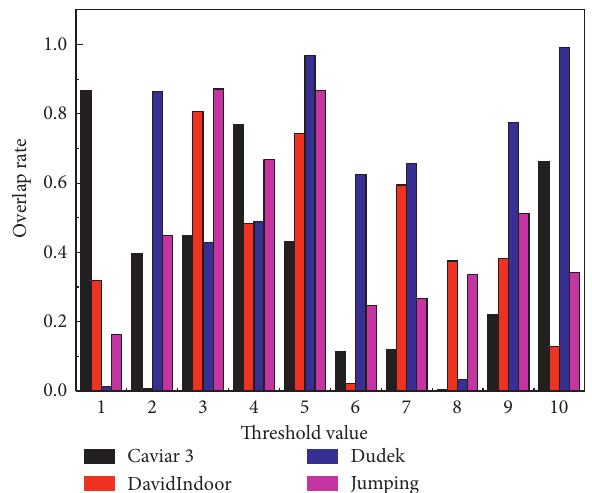
Figure 5: Overlap rate of different threshold algorithms on four test sequences.